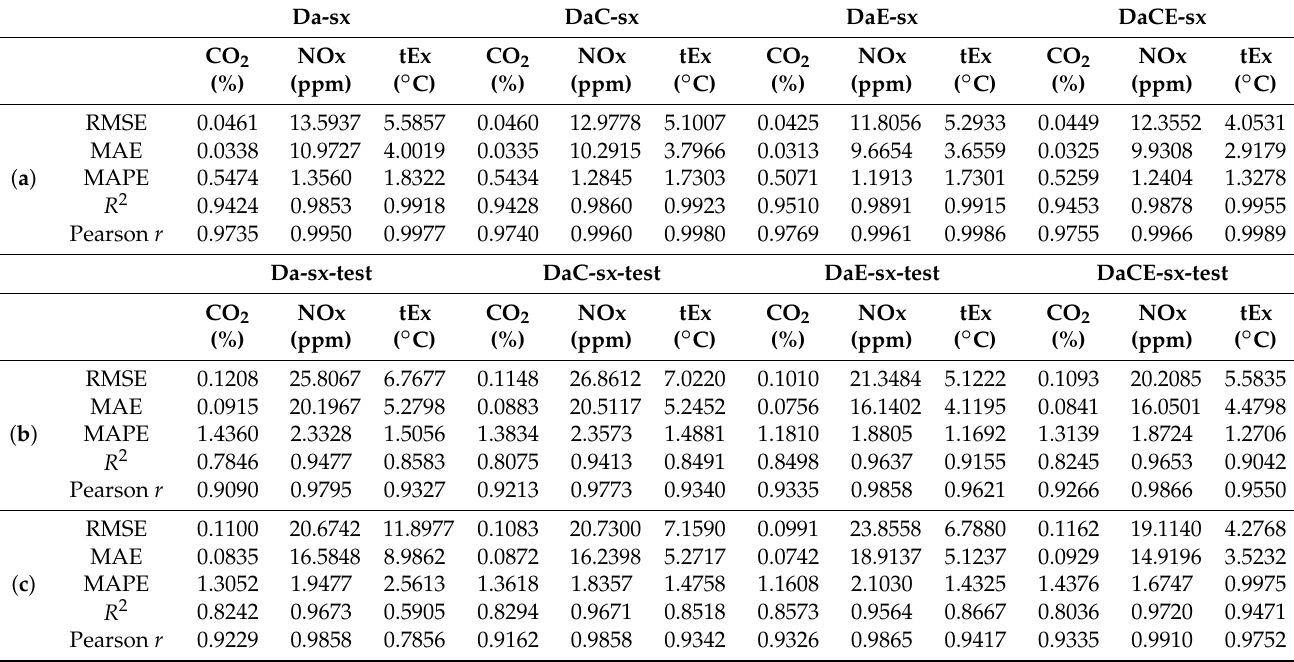
Table 8. Metrics from different datasets for the ANN model with the no-SCR mode ( a ) trained 15 times from the ATC training set with average taken of the 15 metrics from the validation set; ( b ) 15 trained models tested from the BTC with average taken of the 15 metrics; ( c ) the best model for the validation set tested from the BTC and its